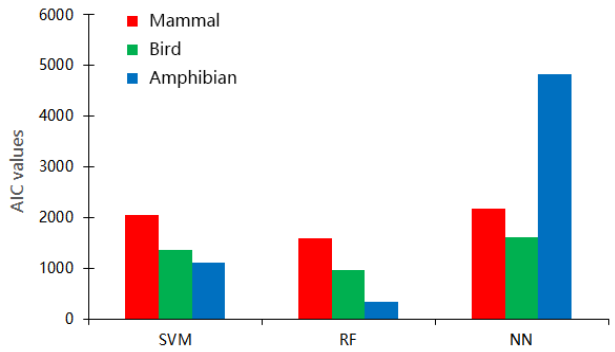
Figure 6. The Akaike information criterion (AIC) values of the three models.